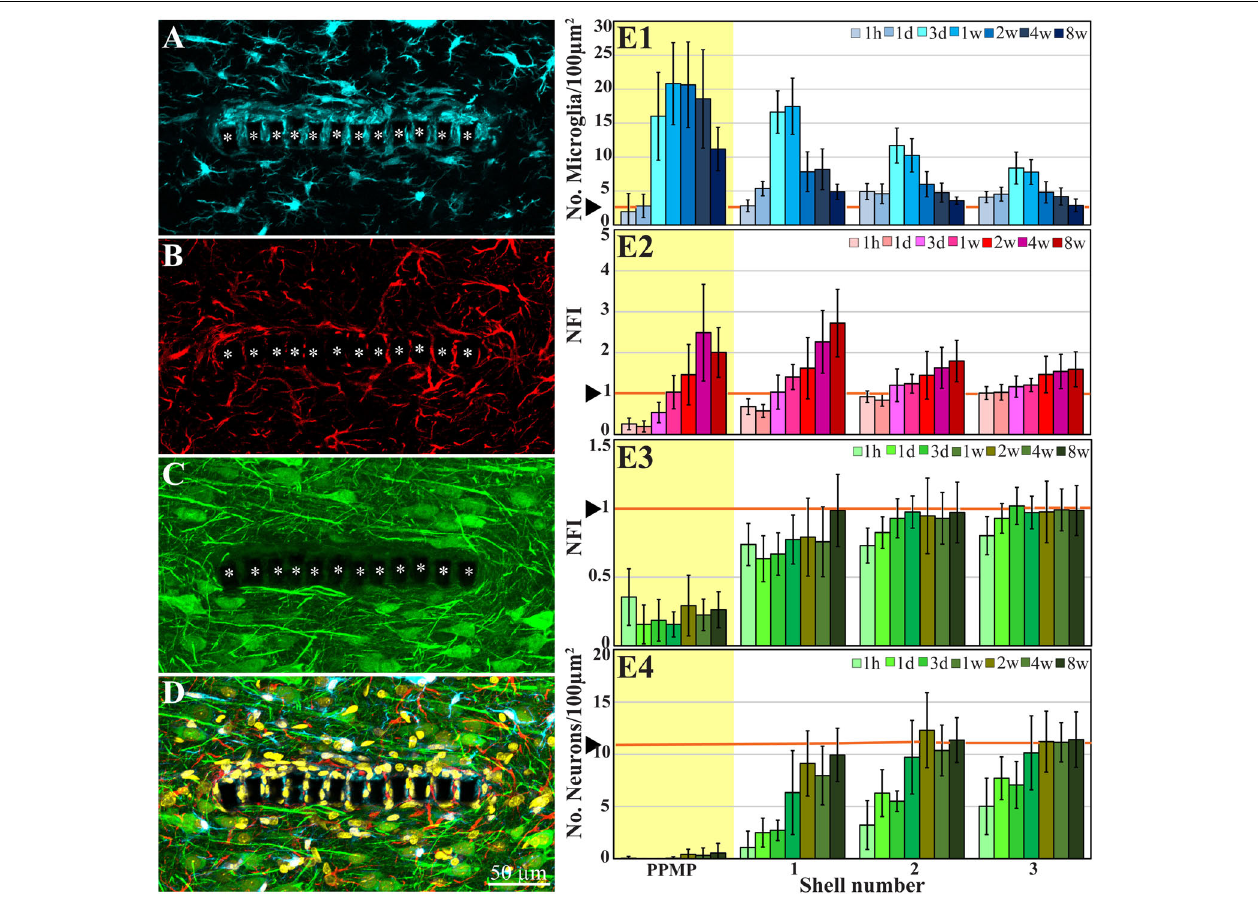
FIGURE 2 | Confocal microscope images showing horizontal-sections of immuno-labeled cortical brain tissue along with cross sections of the perforated segment of an implanted PPMP, 2 weeks post implantation. Shown are: microglia (cyan) within and around the implant marked by asterisks (A) , astrocytes ( B , red), neurons and neurites ( C , green), and a merged image of (A–C) which also includes the nuclei of the cells labeled in yellow (D) . (E) Histograms depicting the average Normalized Fluorescent Intensity (NFI) or number of cells/100 µ m 2 . Microglia ( E1 , cyan), astrocytes ( E2 , red), neurites and cell bodies ( E3 , green), and neuronal cell bodies ( E4 , green) within and around the platform’s perforated segments. The time post-platform implantation is coded by the darkening of the column color as indicated by the legend on the right hand side of the histograms. The average NFI values or the cells/100 µ m 2 within the platforms (PPMP) are highlighted in yellow. The distance of the average NFI from the MEA platform is given by shell number. Each shell is 25 µ m wide (as illustrated in Figure 1F ). Vertical lines correspond to one standard deviation. The orange lines indicated by the arrowheads depict the normal NFI values or the number of cell/100 µ m 2 in the control cortices. An enlarged image of (D) is presented as Supplementary Figure 2